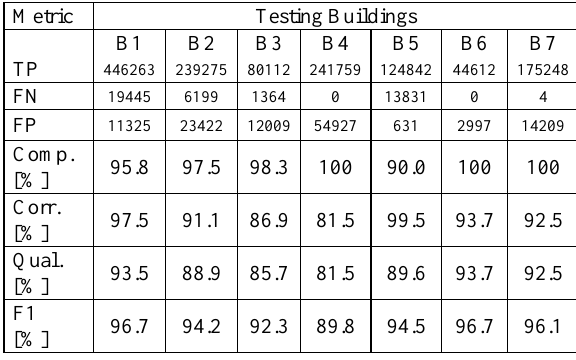
Table 4. The accuracy of the building